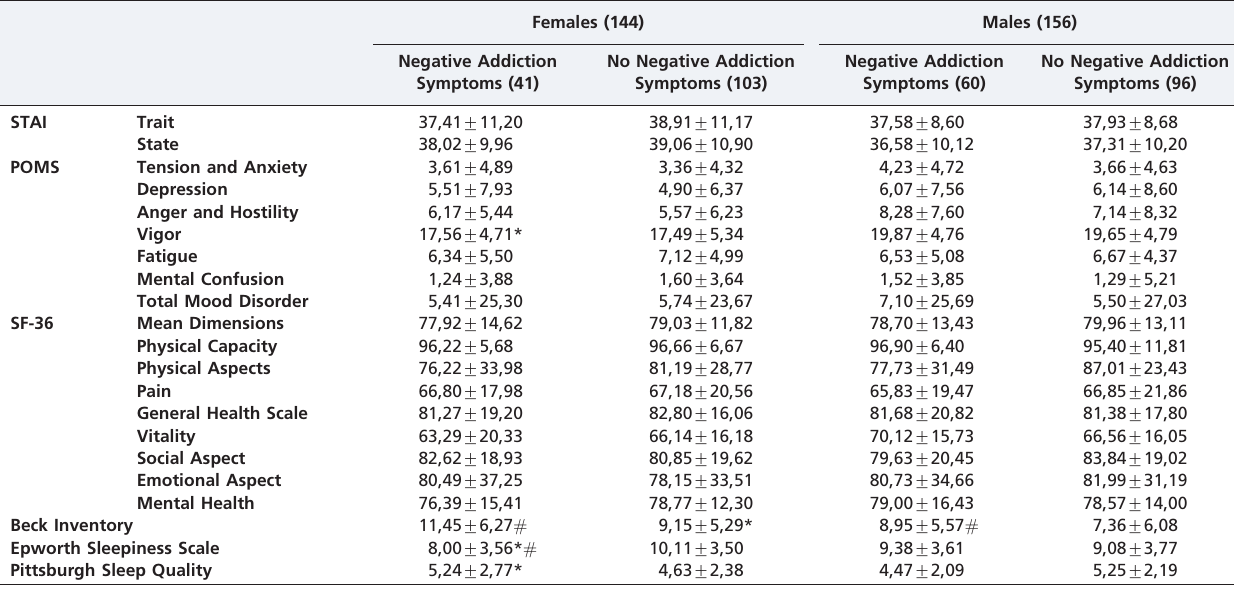
Table 2 - Quality of Life, mood and